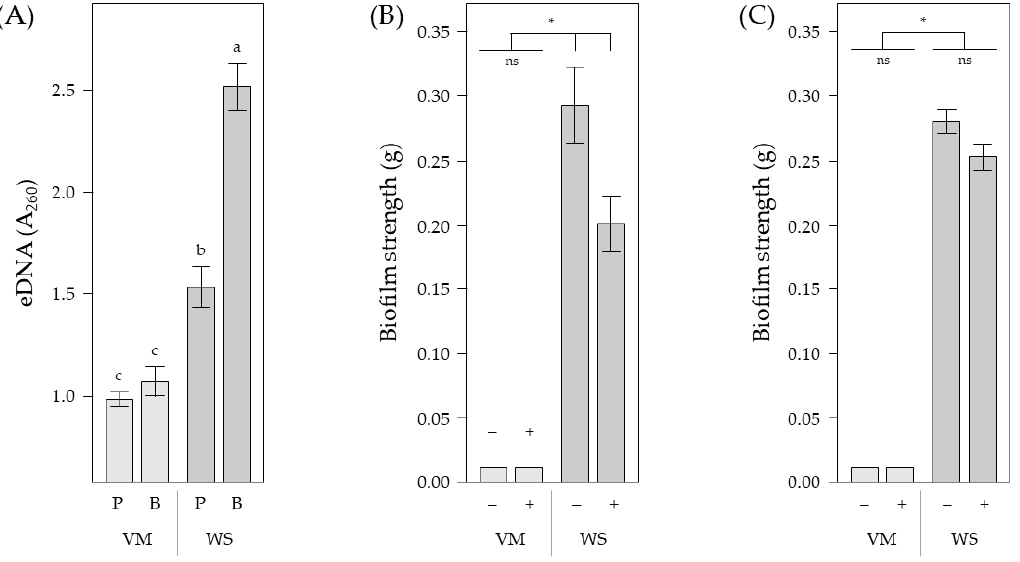
Figure 3. Quantitative measurements of eDNA and the impact it has on biofilm strength. Spectrom- etry was used to measure eDNA recovered from planktonic cultures and biofilms, and small glass balls to determine biofilm strength. Shown here are eDNA (A 260 ) levels ( A ) in 24 h planktonic and three-day-old biofilm samples (B, biofilm sample; P, planktonic (shaken) culture sample; VM, Viscous Mass; WS, Wrinkly Spreader). Biofilm strengths (grams) are shown ( B ) for three-day-old biofilms which developed in microcosms with DNase I before assay, and ( C ) for three-day-old biofilms treated with DNase I for 3 h before assay (+, with; − , without). Means ( n = 6–8) ± SE are shown. Differences between means ( A ) were determined for each set of measurements by one-way ANOVA and post hoc Tukey–Kramer HSD tests. Means sharing the same letter are not significantly different ( α = 0.05). Differences between means ( B , C ) were determined by the Wilcoxon method. Means linked by an asterisk are significantly different ( p < 0.05) (ns, not significantly